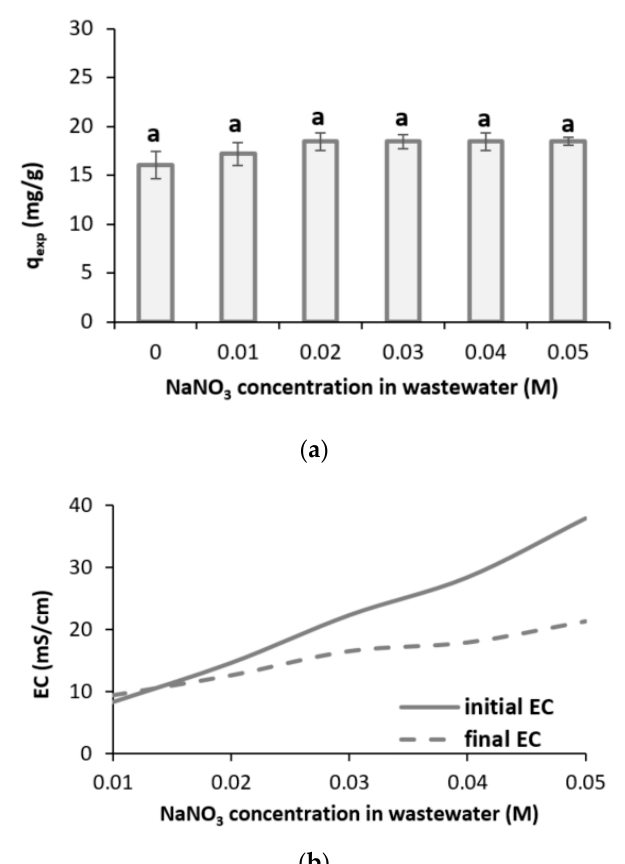
Figure 8. Effect of wastewater salinity (as electrical conductivity, EC) on Cd adsorption onto poultry ash: ( a ) adsorption capacity, ( b ) changes in initial (before adsorption) and final (after adsorption) salinity in wastewater (Cd concentration = 100 mg/L, adsorption time = 24 h, pH = 5). Error bars represent standard deviations ( n = 3). Different letters above bars would indicate significantly different adsorption capacities at different concentrations of NaNO 3 in wastewater (ANOVA followed by Tukey’s honest significant difference test, p < 0.05).